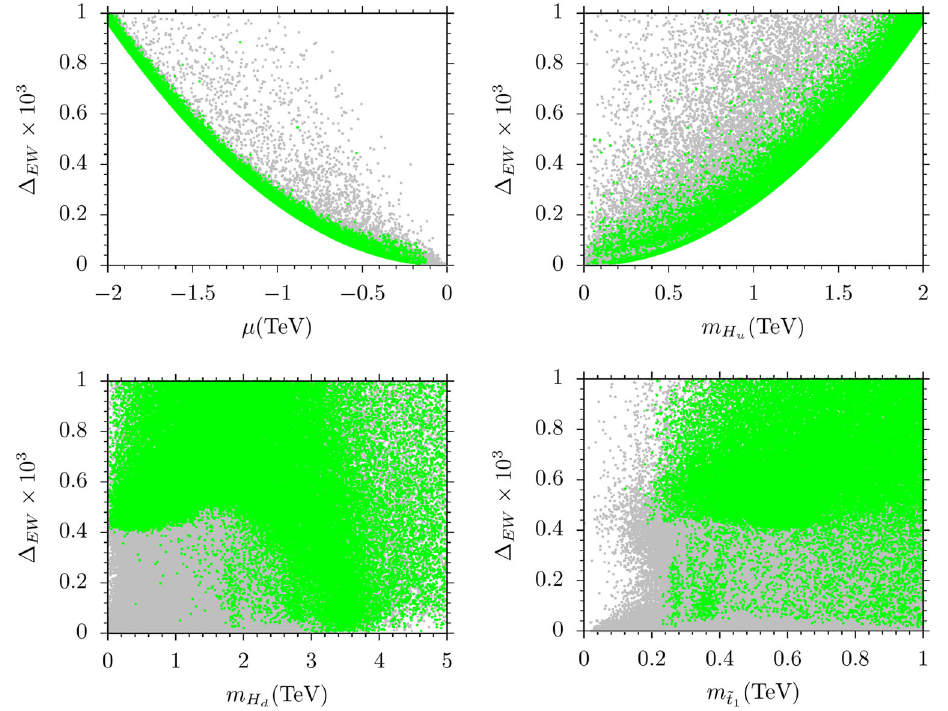
,(cid:2) − m (cid:2) − m ˜ EW H d , and EW t planes. All points are consistent with REWSB and neutralino LSP. Gray u